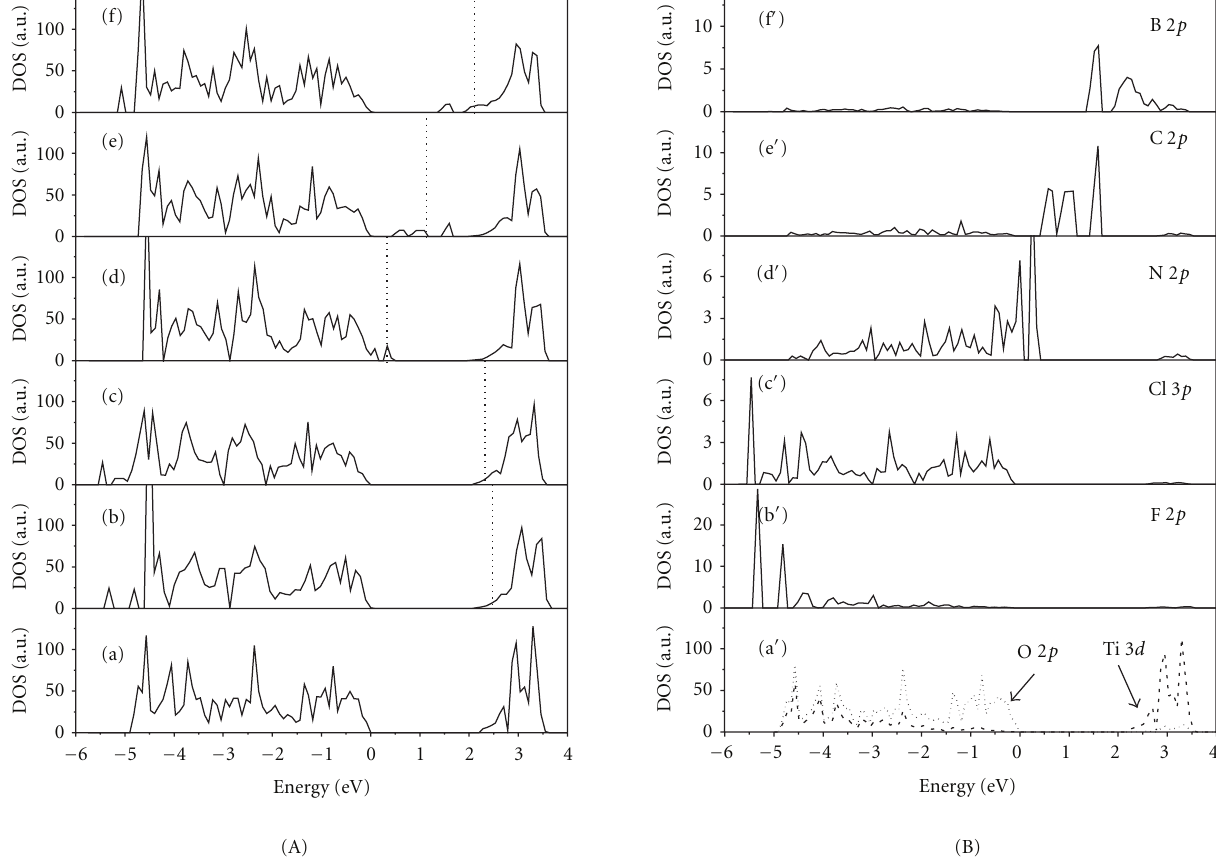
Figure 2: Total densities of states (A) and projected densities of states (B) for (a) pure anatase TiO 2 , (b) F-doped TiO 2 , (c) Cl-doped TiO 2 , (d) N-doped TiO 2 , (e) C-doped TiO 2 , and (f) B-doped TiO 2 . The vertical dash line defines the highest occupied